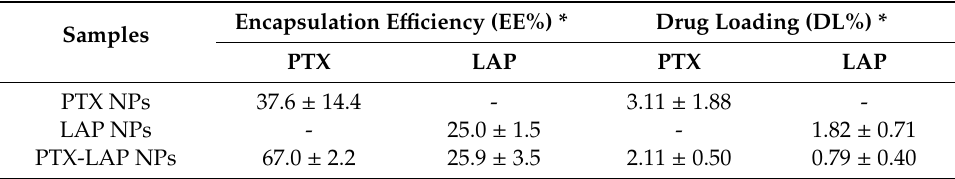
Table 3. Encapsulation e ffi ciency and drug loading of nanoparticles.